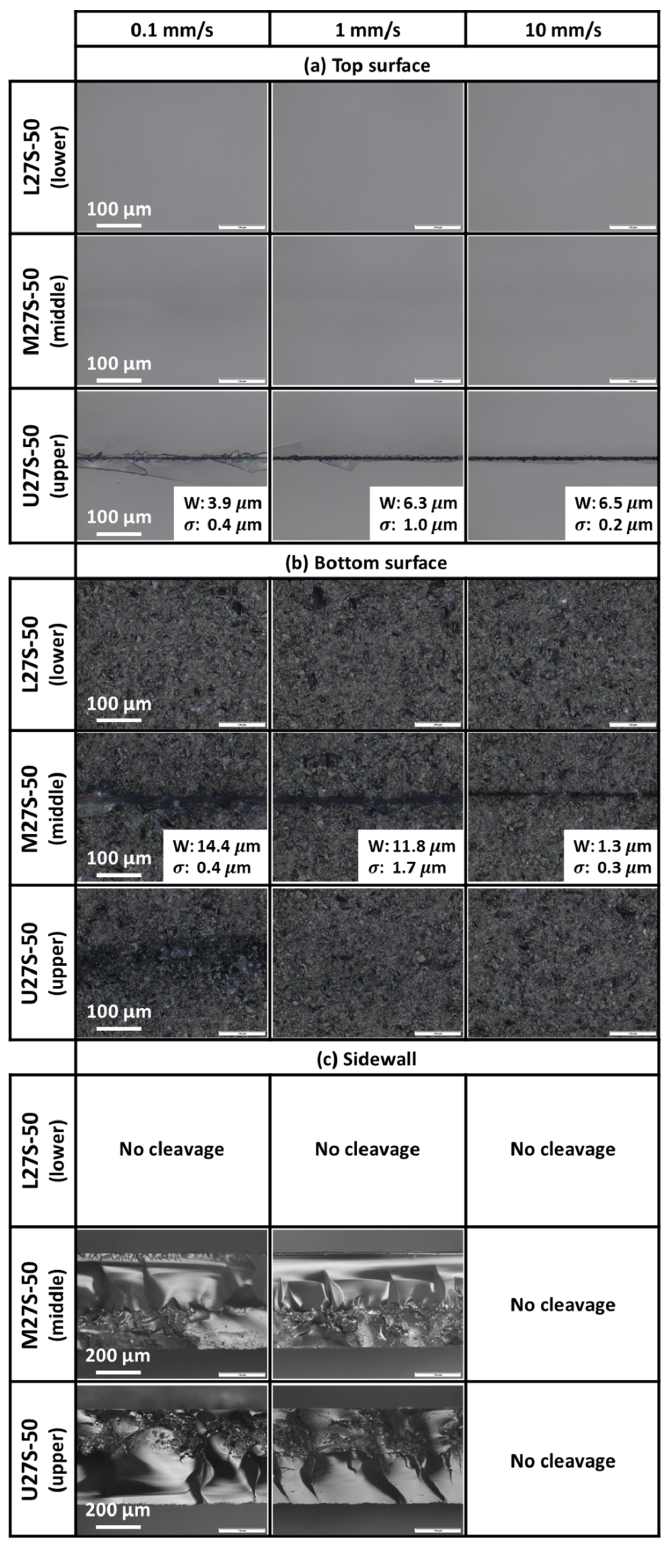
Figure 7. Optical images of ( a ) top polished entry surface, ( b ) bottom unpolished exit surface and ( c ) sidewall profiles after one-third section at 0.80 W scanning with the respective widths (W) and standard deviations ( σ